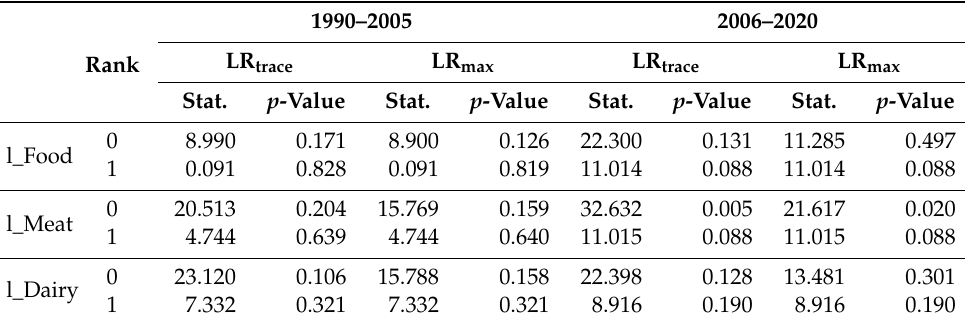
Table 4. Cointegration results for oil and food price